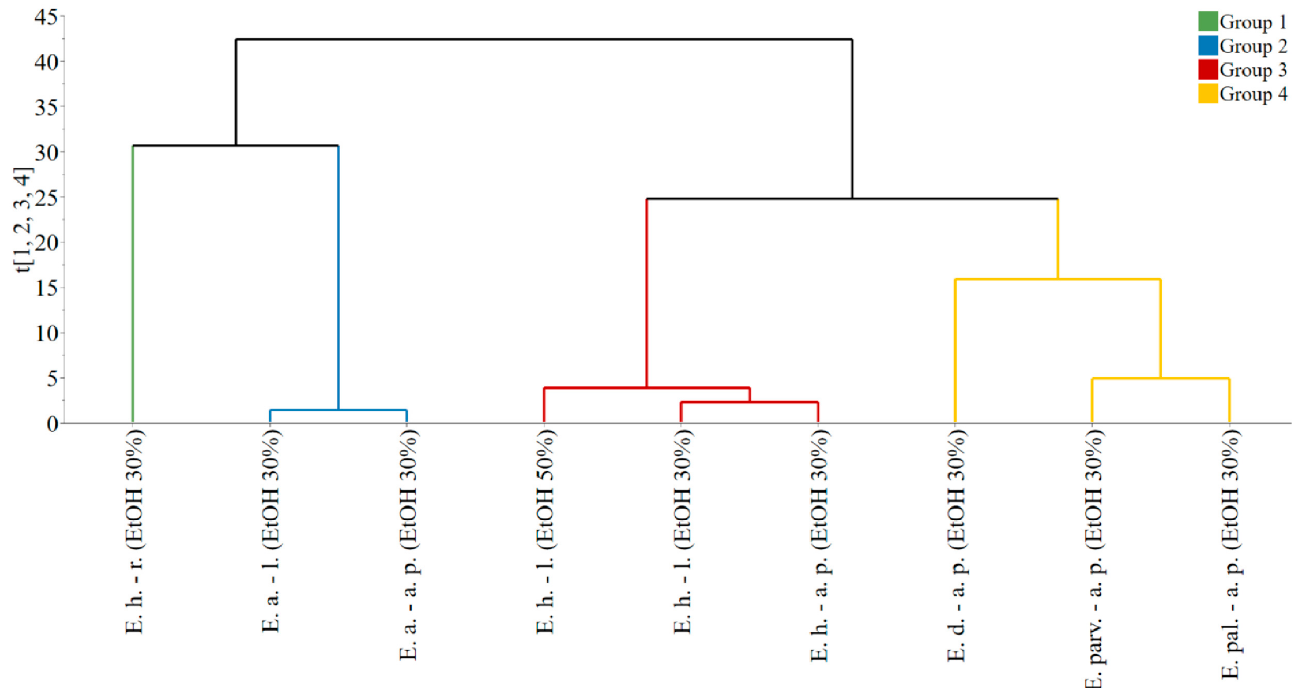
Figure 2. Dendrogram presenting the grouping of observations based on the score vectors of the PCA model. Legend: E. h.–l.— E. hirsutum leaves. E. h.–a. p.— E. hirsutum aerial parts. E. h.–r.— E. hirsutum roots. E. parv.–a. p.— E. parviflorum aerial parts. E. pal.–a. p.— E. palustre aerial parts. E. d.–a. p.— E. dodonaei aerial parts. E. a.–l.— E. angustifolium leaves. E. a.–a. p.— E. angustifolium aerial parts. EtOH 50%—ethanol in water 50/50 ( v/v ). EtOH 30% — ethanol in water 30/70 ( v/v ).